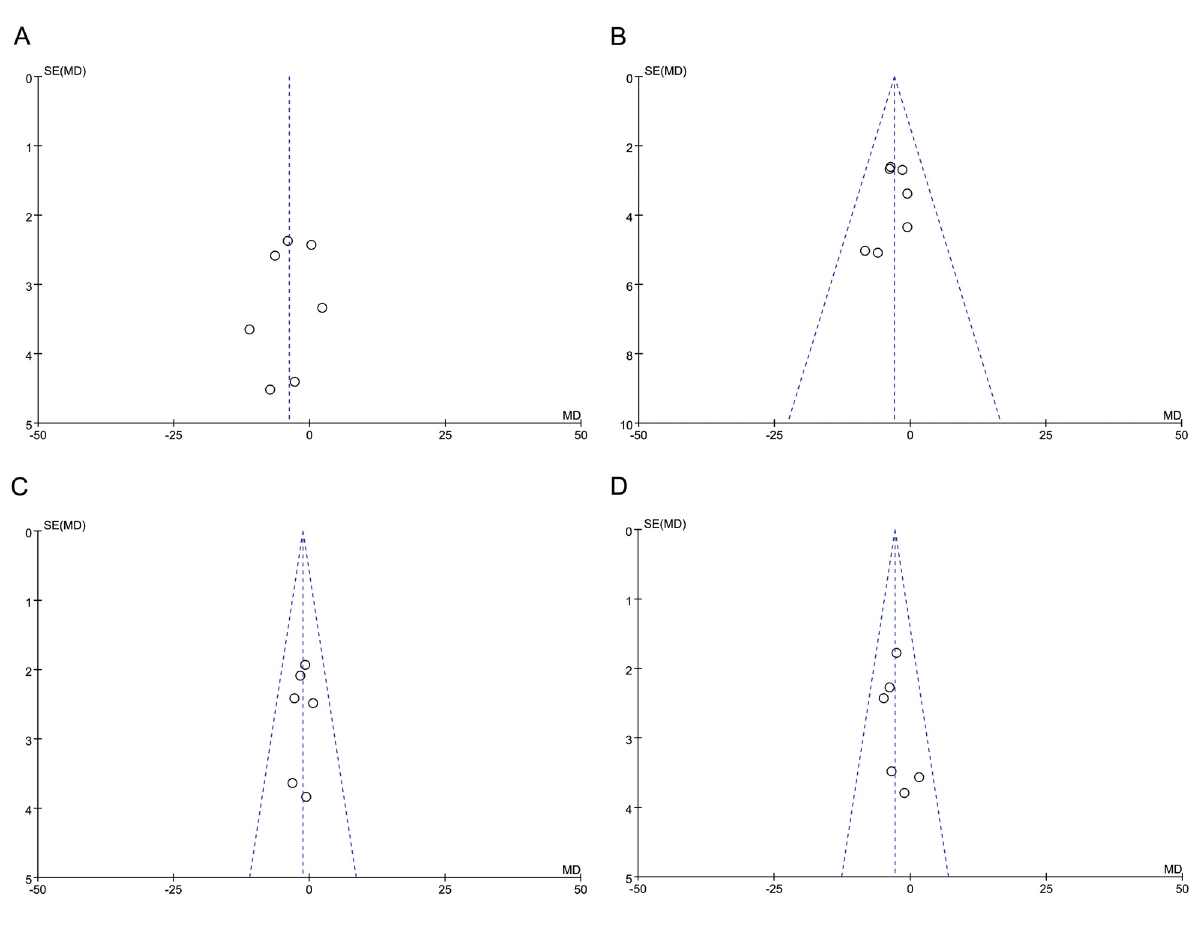
PLOS ONE | DOI:10.1371/journal.pone.0125919 May 12,